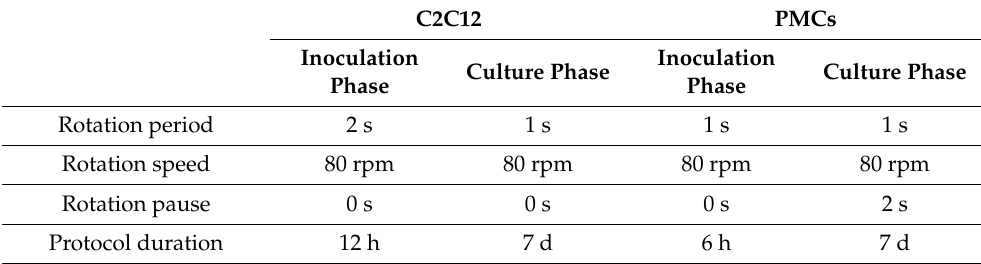
Table 2. Parameters for suspension culture using the CERO 3D Incubator and